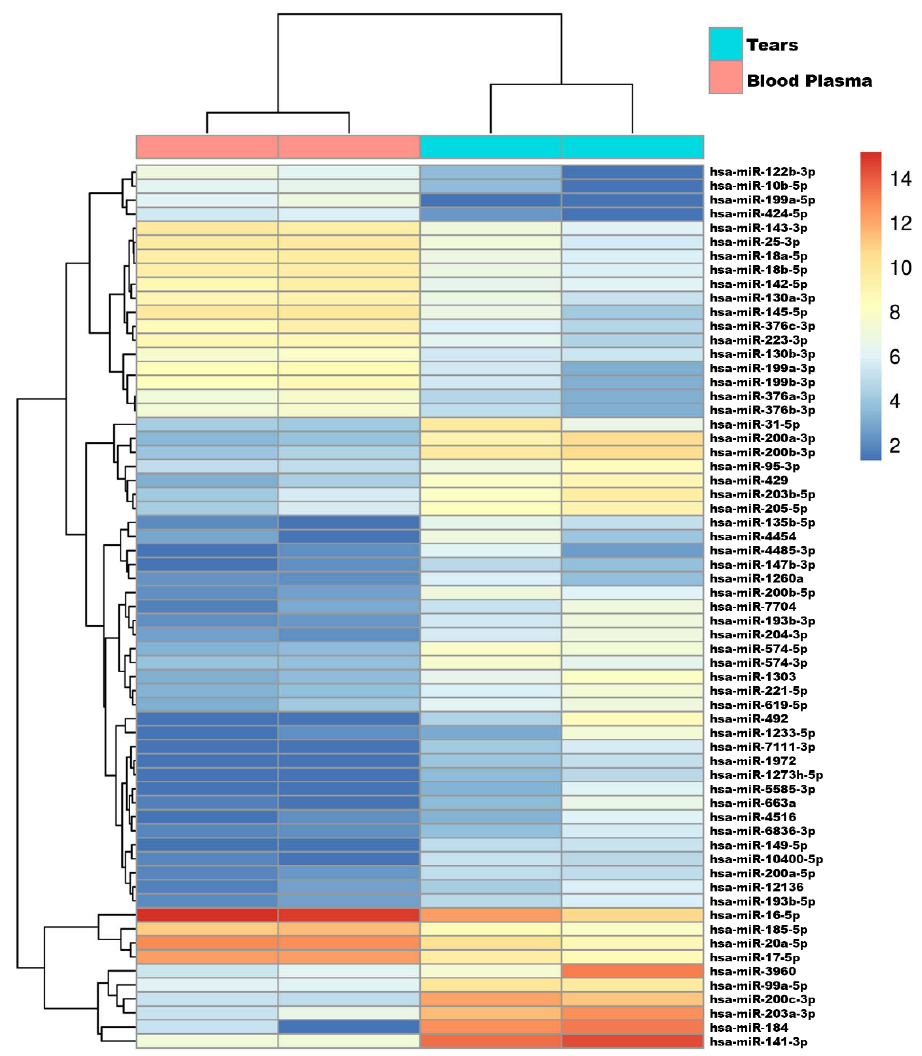
Figure 2. The heatmap represents the cluster analysis of miRNA log fold change in tears and plasma ( p < 0.01).